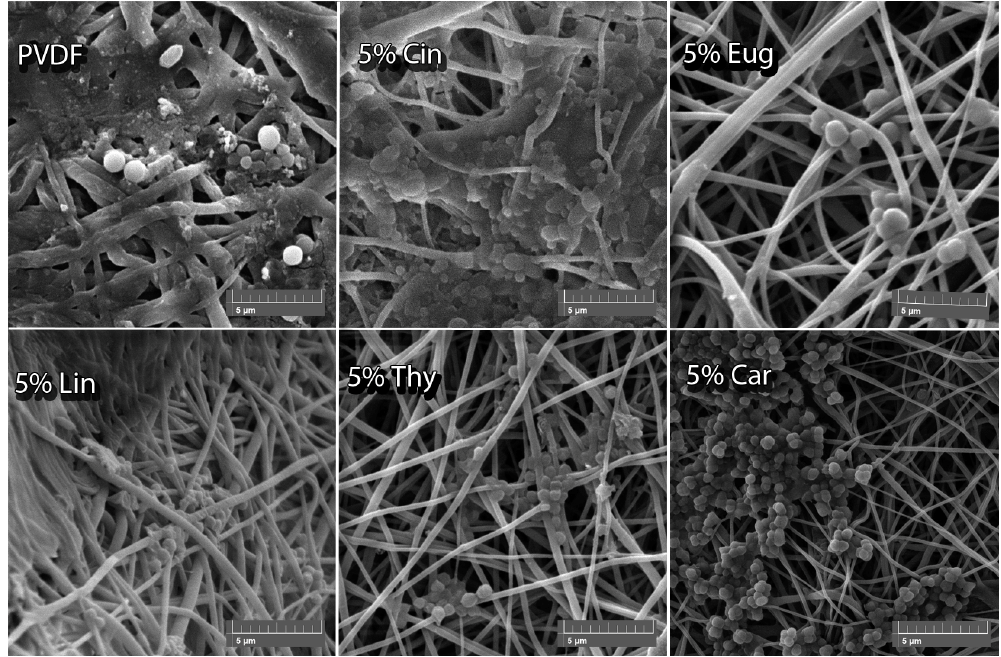
Figure 3. Biofilm formation SEM images of pure PVDF nanofibers and with individual EOs in the presence of S. aureus. Table 5. Biofilm formation in the presence of PVDF